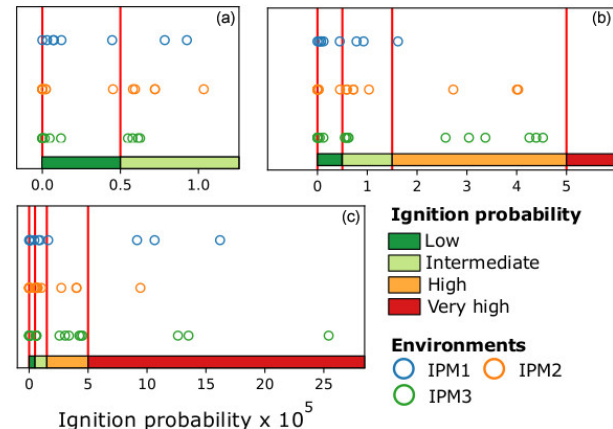
Figure 9. (a) Frequency of the calculated probabilities in the ig- nition probability maps constructed with land cover class; (b) land cover class and soil type; and (c) land cover class, soil type, and land use class. The four probability class intervals are indicated by red lines.